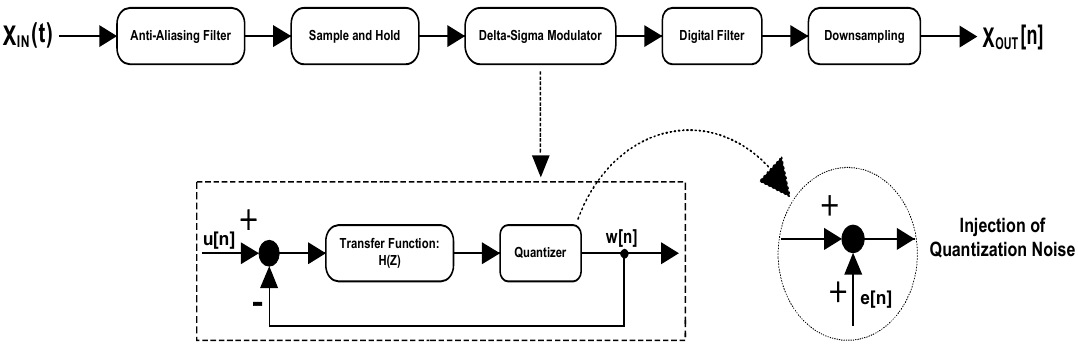
Figure 1. The delta-sigma analog to digital converter architecture along with a general model for the delta-sigma